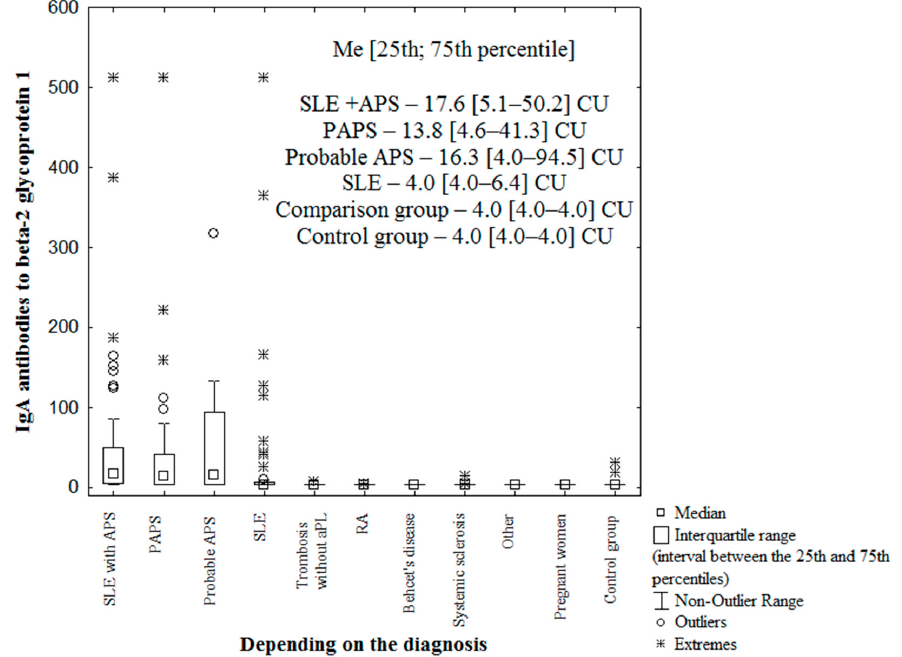
Figure 3. Levels of IgA antibodies to beta-2 glycoprotein 1 (IgA anti- β 2 -GP1) in patient groups. Note: SLE-systemic lupus erythematosus; APS–antiphospholipid syndrome; aPL-antiphospholipid antibodies; RA-rheumatoid arthritis; other-two patients with polymyositis, one of whom had thrombosis and one patient with Buerger's endarteritis; Me-median with interquartile range; CU-chemiluminescent units; and the Y axis shows units-CU-chemiluminescent units (IgA anti- β 2 -GP1 unit). The patients were divided into two groups according to IgA anti- β 2 -GP1 positivity: (1) those with positive values (>20.0 CU) and (2) 112 with negative ones (<20.0 CU). tivity for IgA anti- β 2 -GP1 ( χ 2 = 15.00; p < 0.0001) (Table 2). The development of APS was 3.84 times higher in patients positive for IgA anti- β 2 -GP1 than in those negative for the